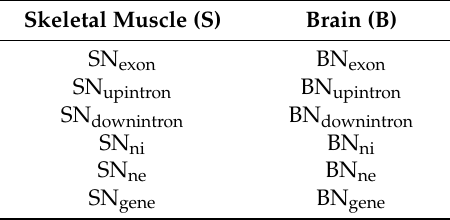
Table 7. The description of all initial features.